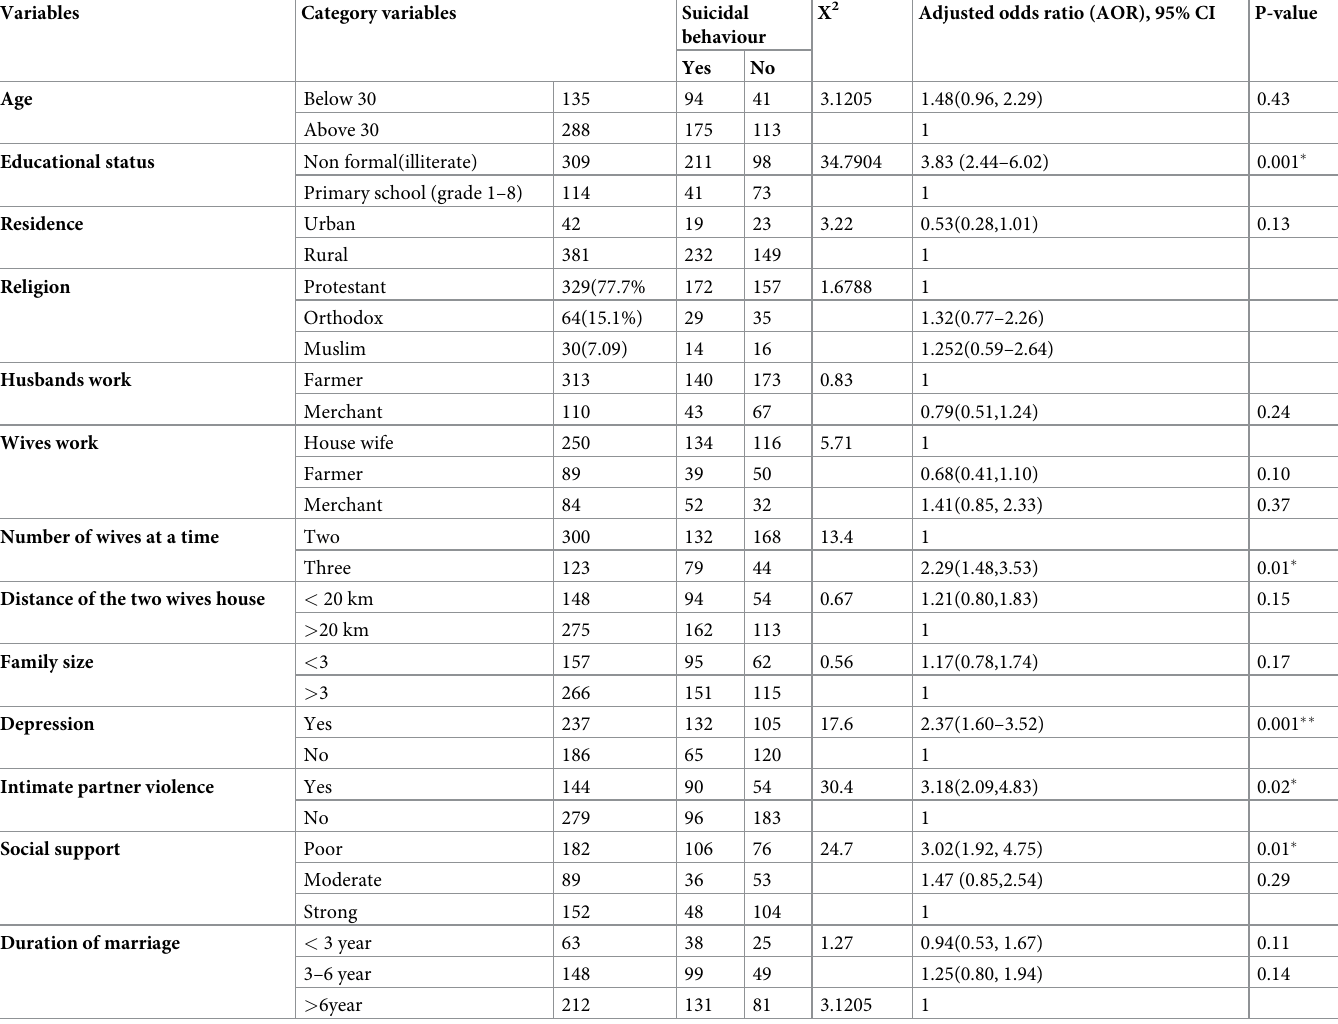
Table 2. Variables associated with suicidal behavior, Dec, 2020 (N =